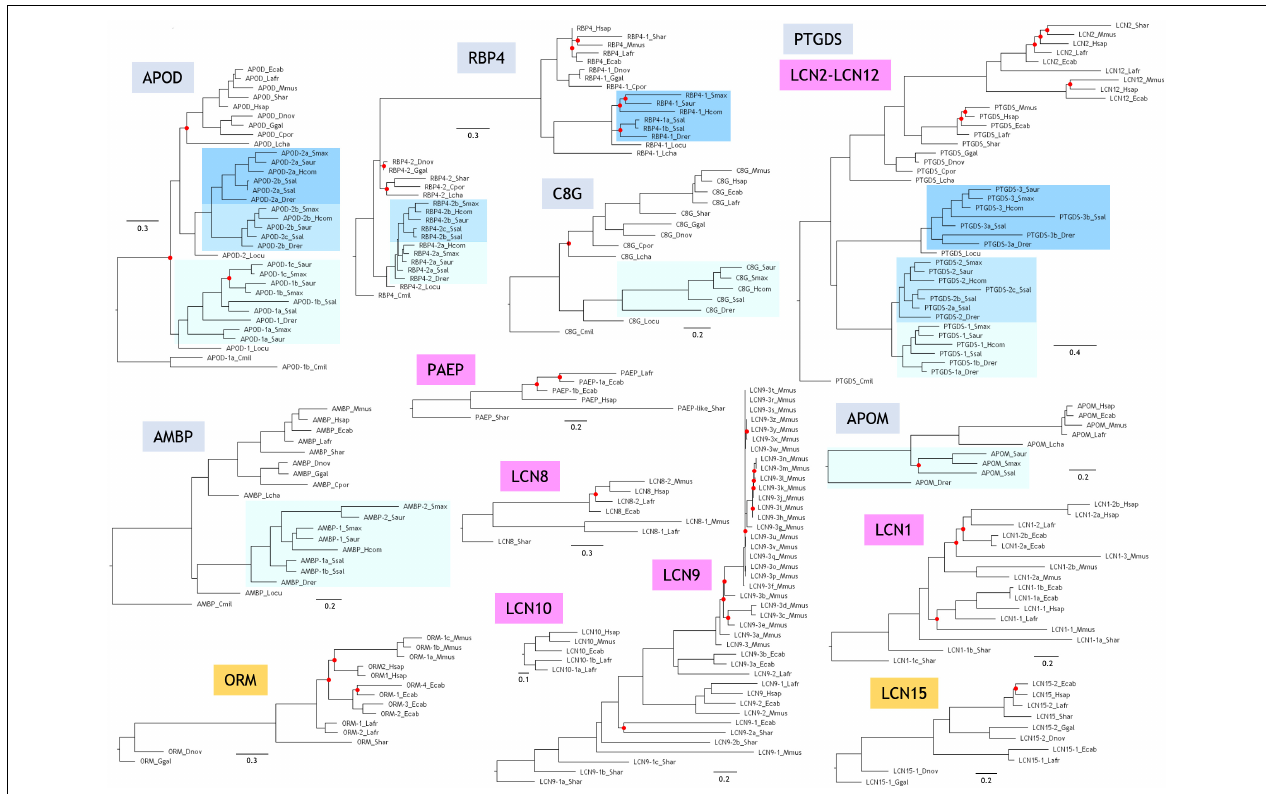
FIGURE 2 | Phylogenetic trees of Lipocalin clades. Each tree is based on structure-based multiple protein sequence alignments and a ML method. Trees were rooted with the Lipocalin(s) of the earliest diverging organism as shown in Figure 1A . Unsupported nodes (bootstrap < 65%) are marked by a red dot. Scale branch lengths represent the number of amino acid substitutions per